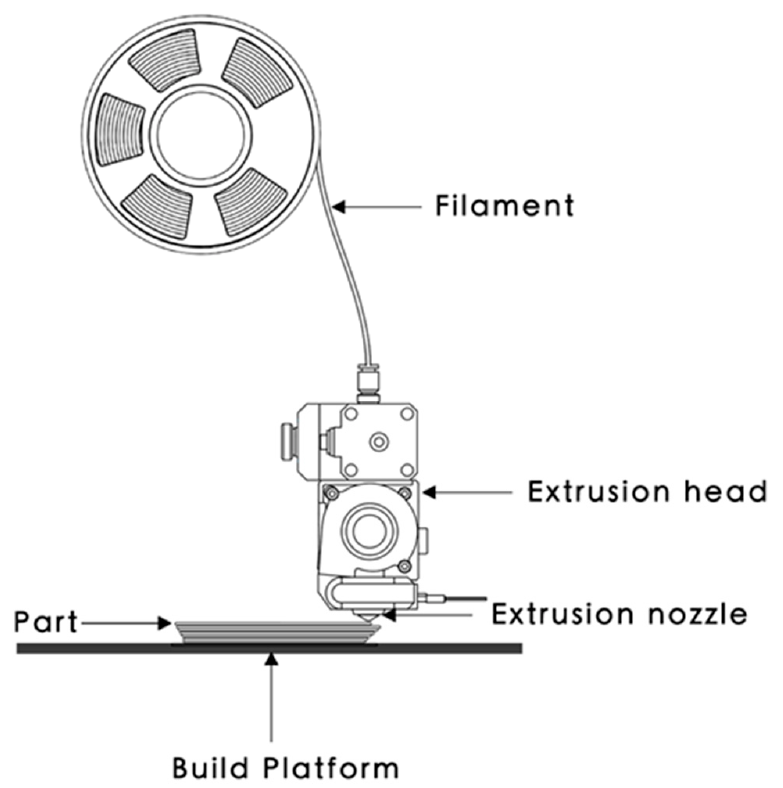
Figure 3. The schematic shows material extrusion (ME) process. Reprinted with permission from